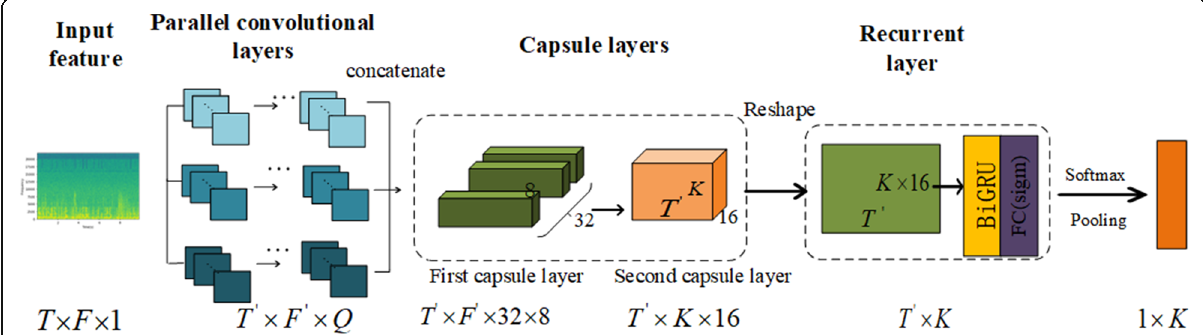
Fig. 6 The proposed neural network structure, which consists of three parts. (1) Feature extraction: parallel convolution layer with different kernel sizes. (2) Capsule layer: the outputs of convolutional layers are fed into two capsule layers. (3) Recurrent layer: a bidirectional GRU and one FC layer are used to learn temporal context information and estimate event activity